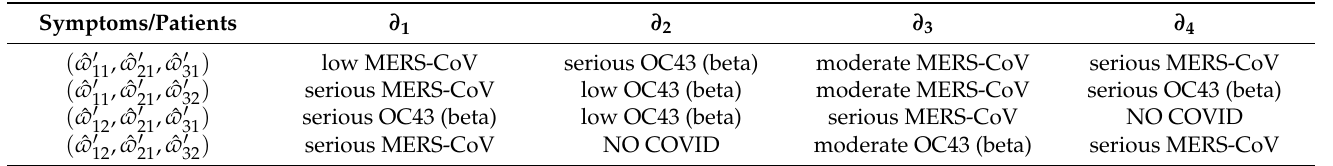
Table 10. Initial treatment chart is developed to assess the validity of the results. Symptoms/Patients ∂ 1 ∂ 2 ∂